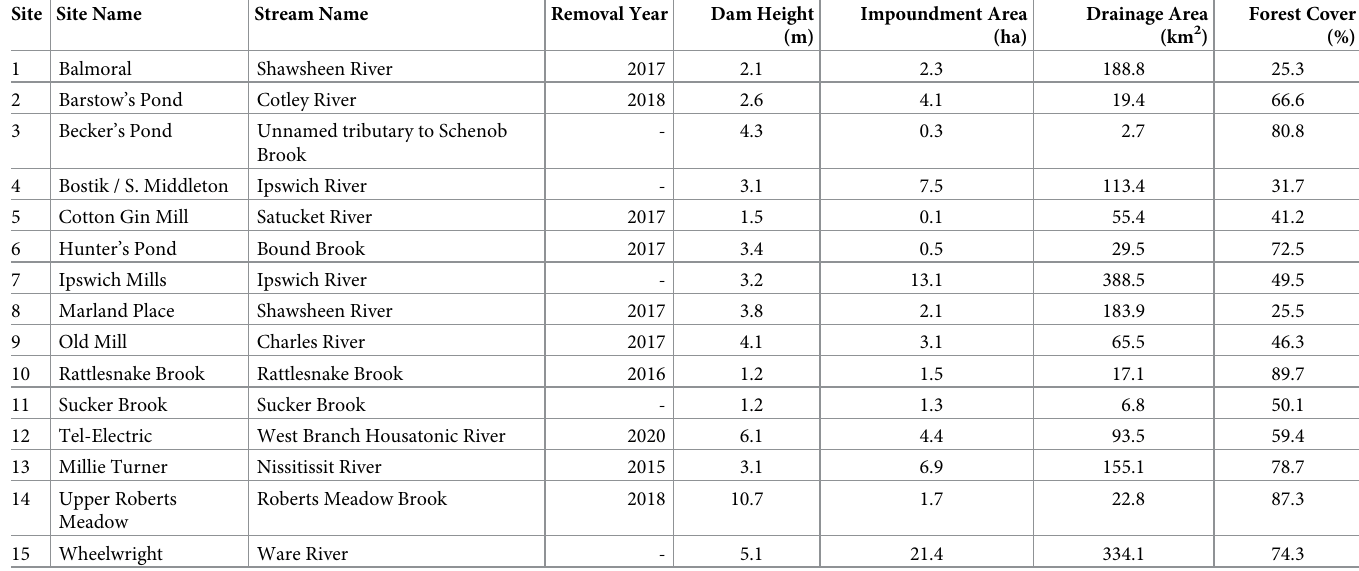
Table 1. Site information for the 15 dams throughout Massachusetts, USA, monitored within this study.